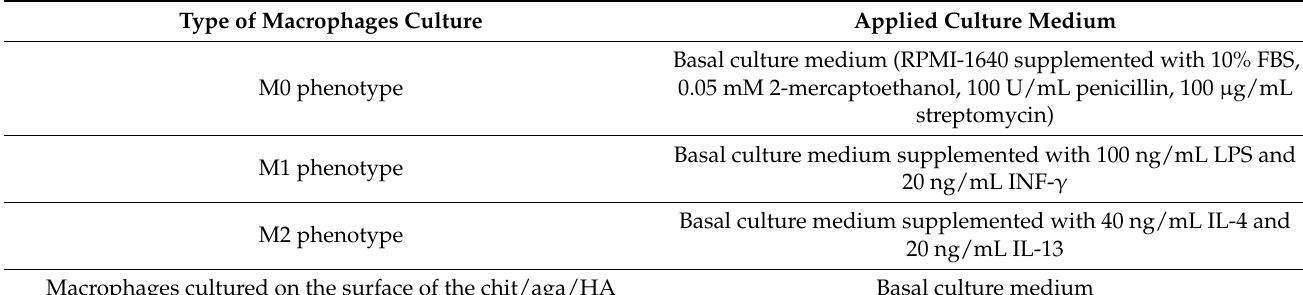
Table 1. Culture media that were applied during macrophage